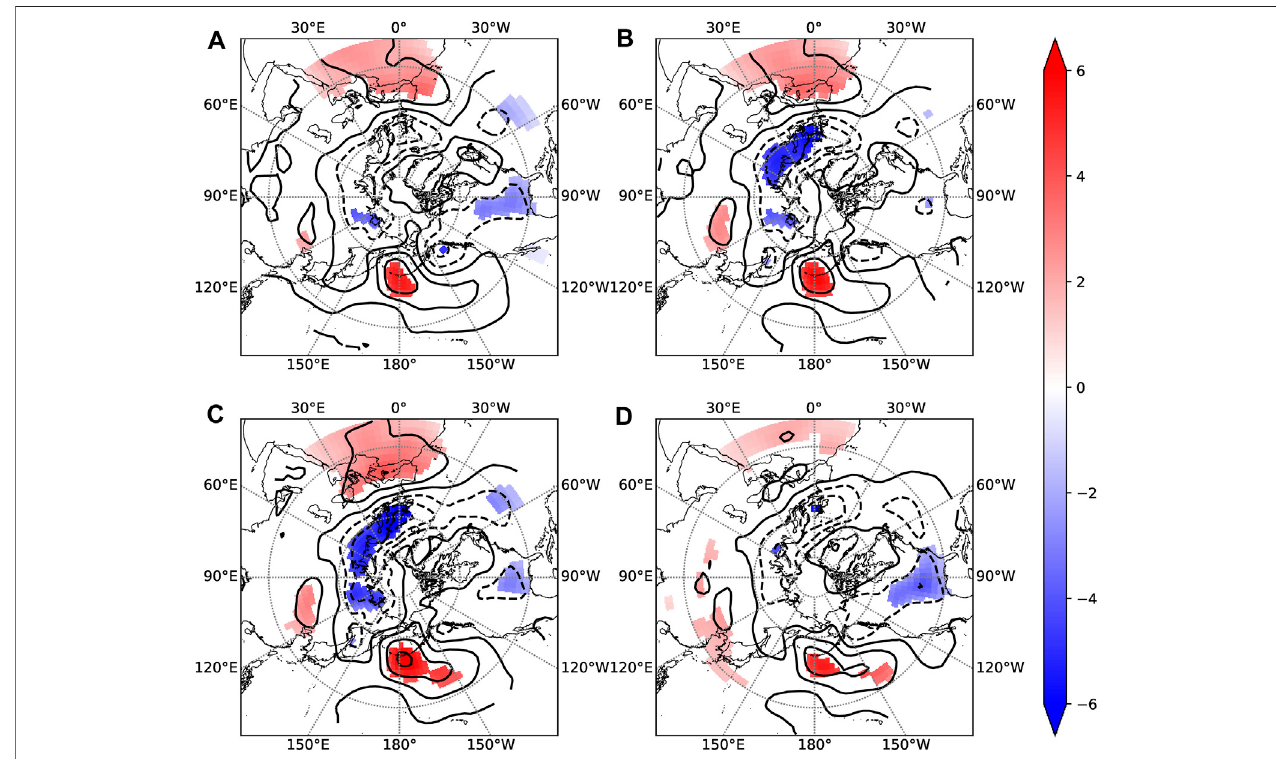
FIGURE2| Compositeof1,000-hPageopotentialheight(GH; contour)anomaliesthatareband-pass fi lteredwithacutoffof10 – 90days.Thecompositeiscarried outintermsofactiveMadden – JulianOscillation(MJO)events(A ≥ 1).Panels (A – D) presentthecompositesthattheMJOleadsGHfor0,5,10,and15days,respectively. Negative (positive) values are presented with dash (solid) lines. Shading areas are signi fi cant at the 5% level based on the Student ’ s t-test.